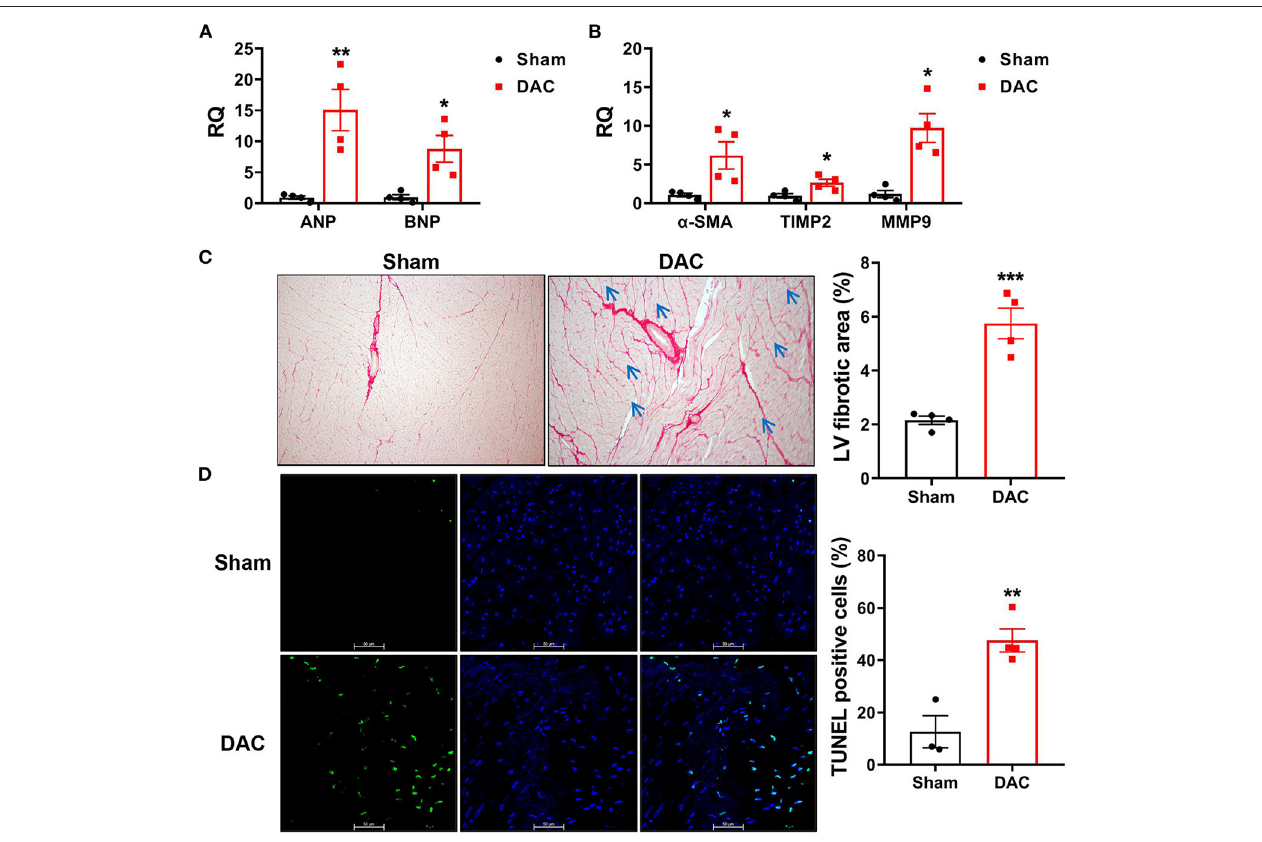
FIGURE 6 | Biomarkers of heart failure, fibrotic area, and apoptosis in the left ventricles. The cardiac injuries at the cellular and molecular levels were seen of the left ventricles of the minipigs with HFpEF. The expression levels of ANP and BNP (A) and α -SMA, TIMP2, MMP9 (B) were significantly higher in the DAC group than those in the sham group. n = 4 minipigs per group. Sirius Red staining showed the fibrotic area in the DAC group was significantly greater than that in the sham group (C) , and the cardiomyocytes in the DAC group displayed hypertrophy (blue arrows), and apoptosis (D) was observed in the myocardium and epicardium of HFpEF. n = 3–4 minipigs per group. All data are presented as the means ± SEMs. * P < 0.05, ** P < 0.01, *** P < 0.001 vs. the sham